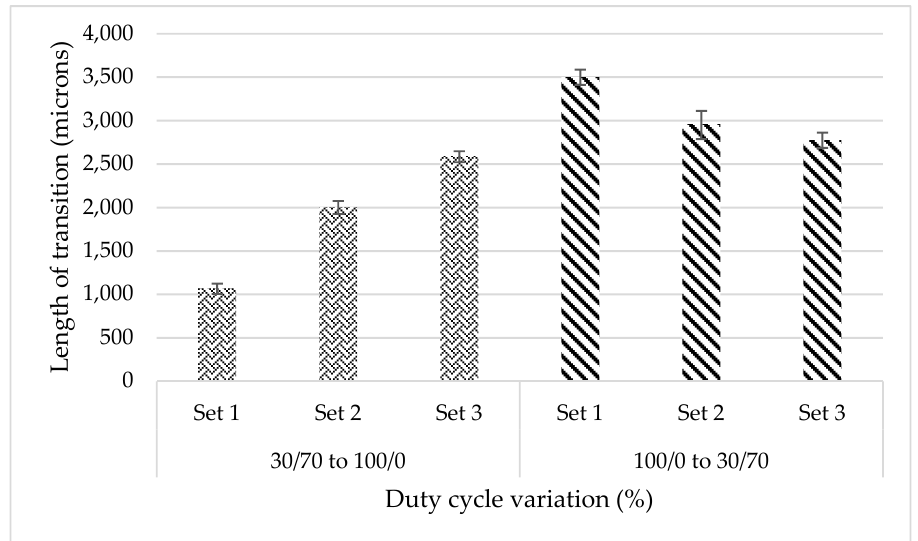
Figure 13. Length of the chemical gradient for the different cases of graded material depositions, as measured from Figures 11 and 12.